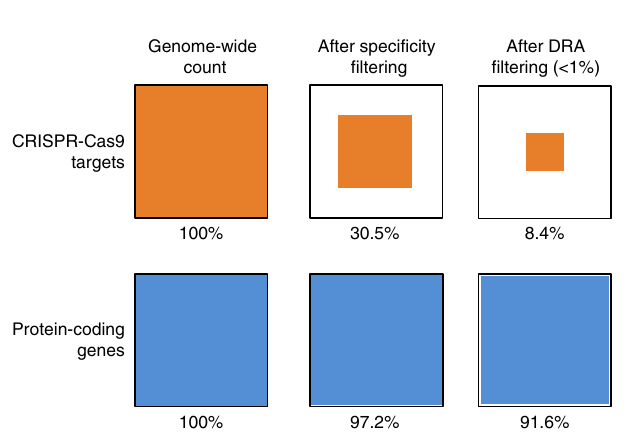
Fig. 1 Sketch of the effect of quality fi ltering on the number of “ good ” targets/genes. Genome-wide count of CRISPR-Cas9 targets (orange) and protein-coding genes (blue) is set to 100% each. During speci fi city fi ltering (GC content between 30 and 70% and no off-targets) and DRA fi ltering (DRA frequency <1%), the number of available targets drops well below 10% (Table 2). Nevertheless, ~90% of all protein-coding genes still contain at least one good target. Colored areas correspond to the values for the combined data of An. gambiae and An. coluzzii . The percentages are similar for Ae. aegypti (not shown). Source data are provided as a Source Data fi Table 2 Effect of polymorphisms on potential targets.